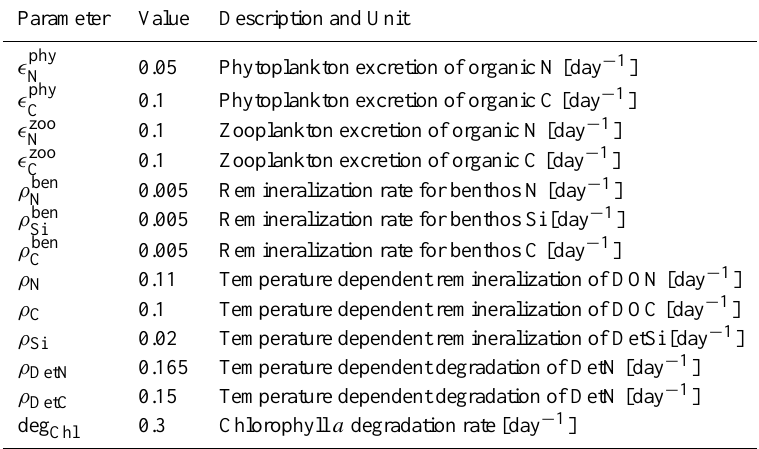
Table A3. Degradation parameters for sources minus sinks equations.